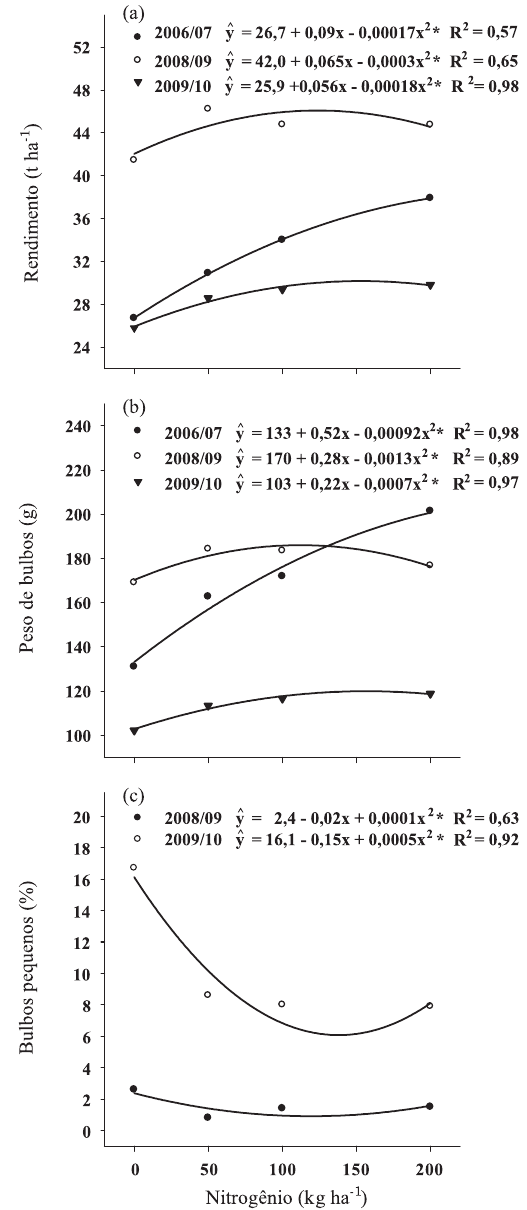
Figura 1. Rendimento (a), peso médio de bulbos (b) e bulbos pequenos (< 50 mm) (c) de cebola em função da adição de doses crescentes de nitrogênio ao solo, em três safras. *: significativo (p ≤